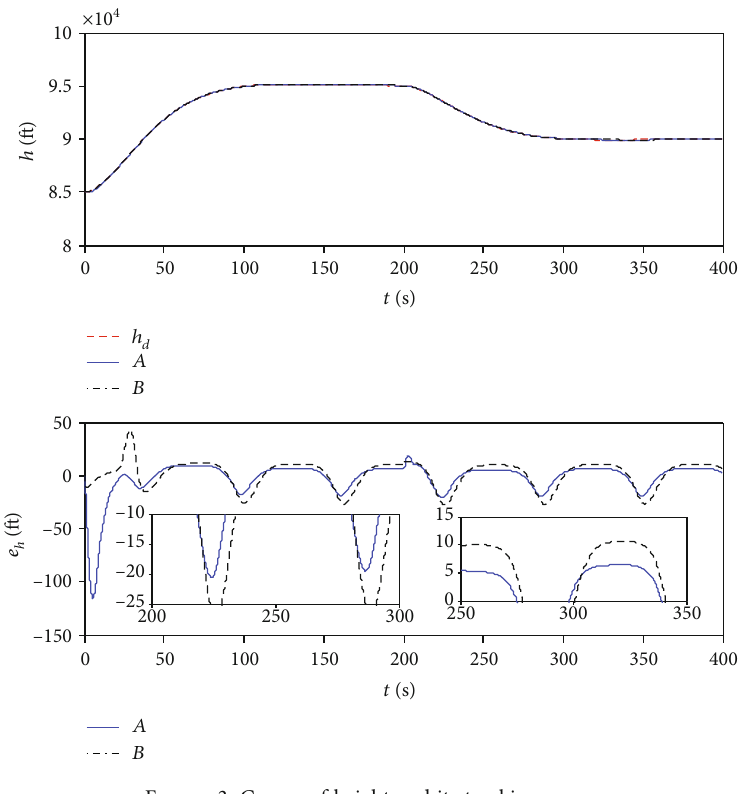
Figure 3: Curves of height and its tracking error.